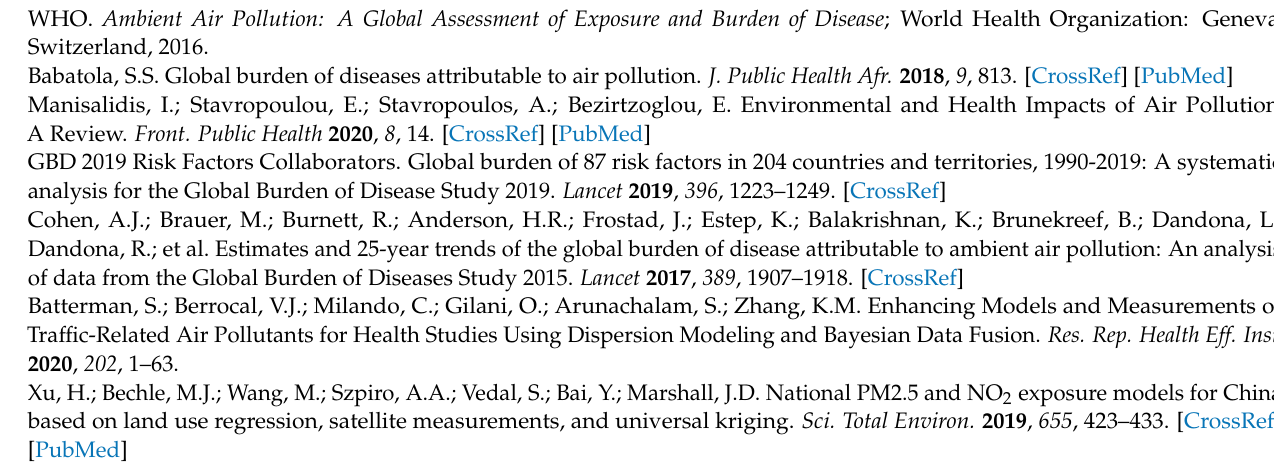
model. *OMINO2 represents tropospheric NO 2 measurements. MR5000, VC1800 & IS7000 stand for major roads (5 km), vegetation cover (1.8 km) and impervious surfaces (7 km), Figure S3 (B): DF-BETA statistics plots for each predictor included in final LUR model. * MR5000, VC1800 & IS7000 stand for major roads (5 km) and vegetation cover (1.8 km), Figure S3 (C). DF-BETA statistics plots for each predictor included in final LUR model. *IS7000 stands for impervious surfaces (7 km), Figure S4: Global Moran’s I Summary for final LUR model residuals, Figure S5: Distribution of mean annual hourly average NO 2 (ppb) concentrations observed at 123 monitoring sites in Ningxia and surrounding areas in 2019, Figure S6: Bland-Altman Plot showing the level of agreement between predicted NO 2 concentrations (using coefficients from 2019 LUR model applied to time-varying predictors) and actual concentrations measured at historical sites (2014 & 2015) not used in model development (n = 41), Figure S7: Predicted vs. observed annual mean NO 2 (ppb) concentrations (2019) with a 1:1 regression line, Table S1: Location and number of monitoring sites by province (year 2019), Table S2: Data sources of predictor variables, Table S3: Results of k-fold cross-validation (5-fold cross-validation, Table S4: Descriptive statistics of annual mean NO 2 (ppb) at model evaluation sites for years 2014 and 2015, Table S5: Independent Evaluation of LUR model at 41 Monitoring sites (Measured NO 2 regressed on Predicted NO 2 using LUR